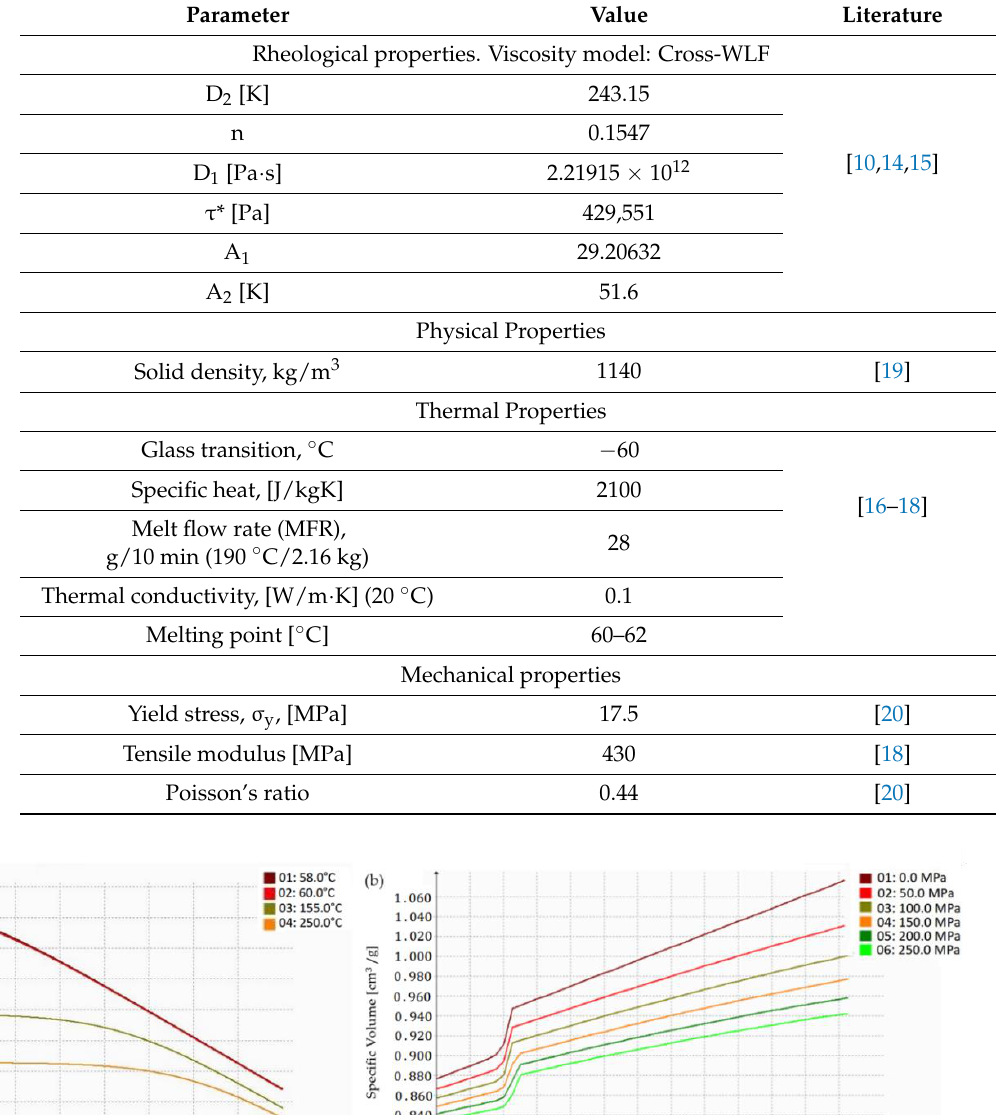
Table 1. Rheological, thermal, and mechanical properties of polycaprolactone needed to build the model, collected from the literature.